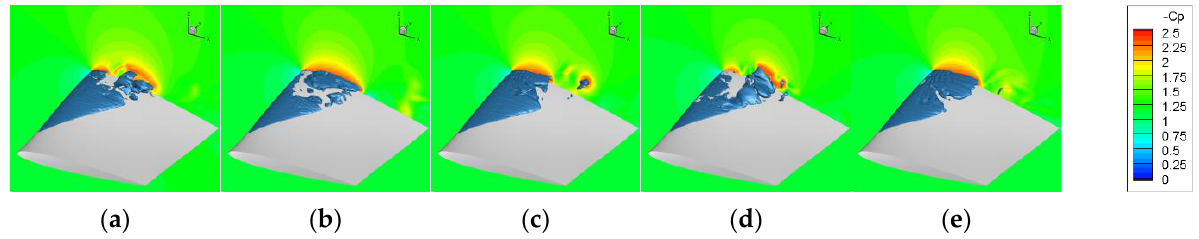
Figure 8. Cavitation features and pressure coefficient of the LES model at y/S = 0.5 according to the time series ( a is at t = 2.040, b is at t = 2.050, c is at t = 2.065, d is at t = 2.075, e is at t = 2.087).